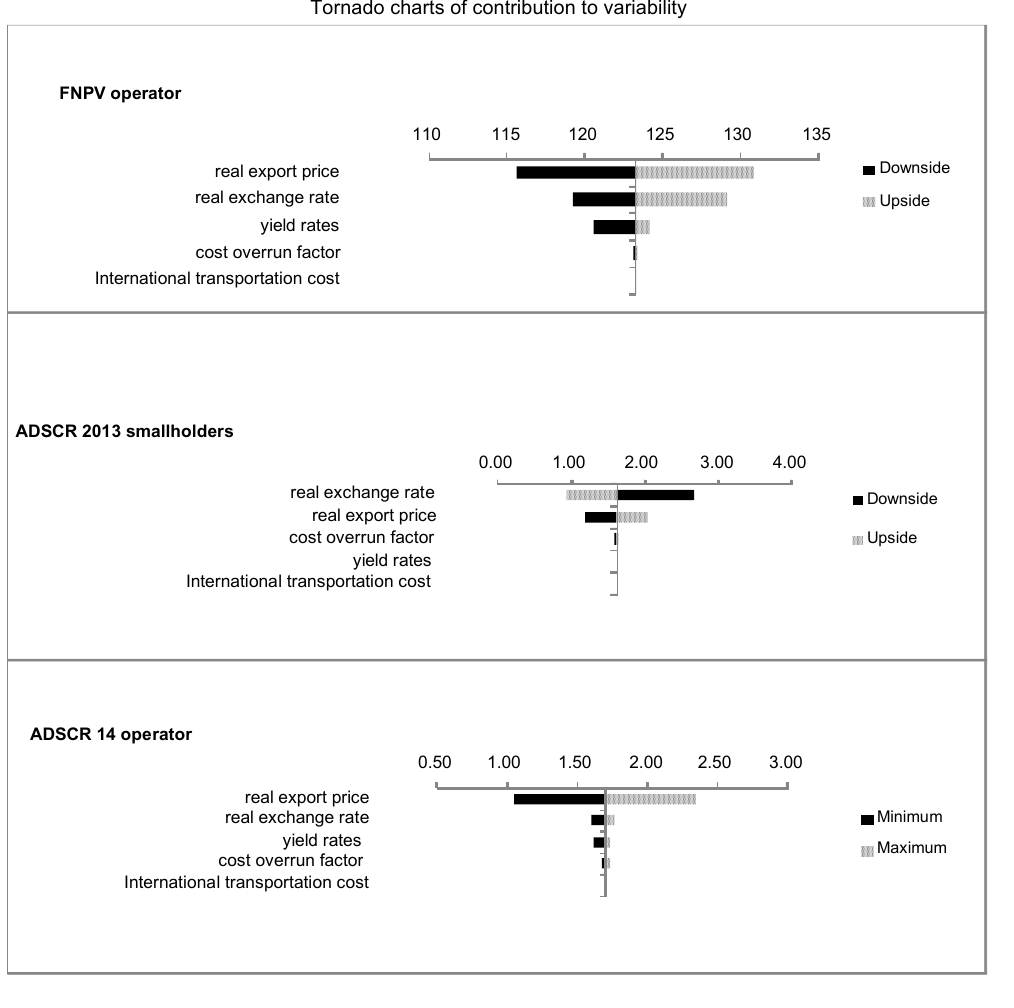
Tornado charts of contribution to